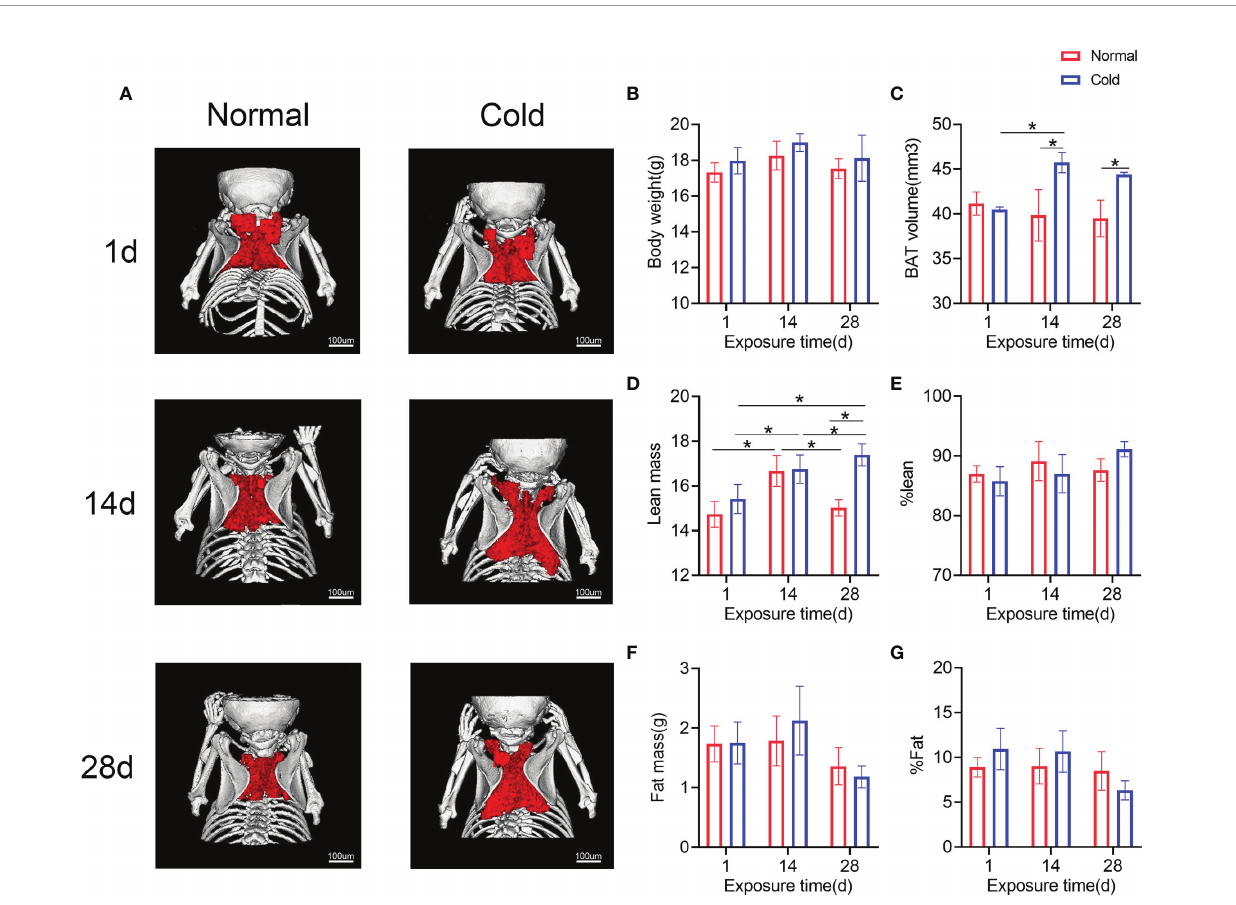
FIGURE 3 | Brown adipose tissue in the interscapula enlarges in response to cold exposure. (A) Reconstruction images of the micro-CT are shown, brown adipose reconstructs with red and bone with white. (B – G) Body weight, brown adipose volume (BAT volume), lean mass, %lean, fat mass and %fat were calculated. Data are shown as the mean ± SD (n=5 per group). Signi fi cance (p-value) was calculated using two-way ANOVA, *p < 0.05; 1 day (1 d), 14 days (14 d), 28 days (28 d), Normal: mice at room temperature (23°C), Cold: mice at